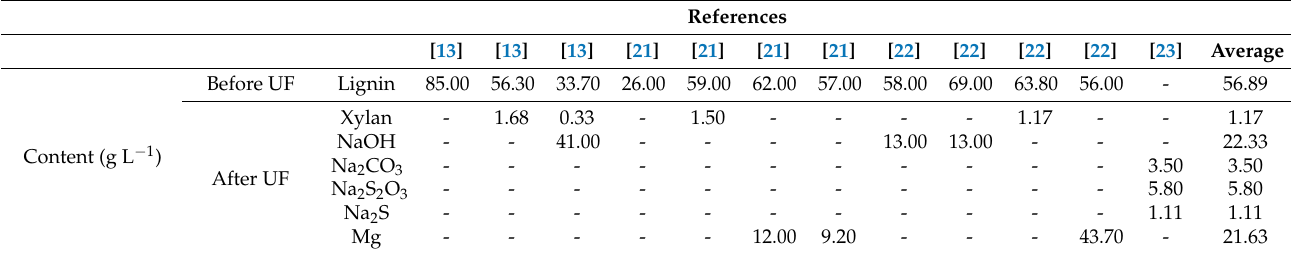
Table 2. Examples of compositions of black liquor reported in literature.